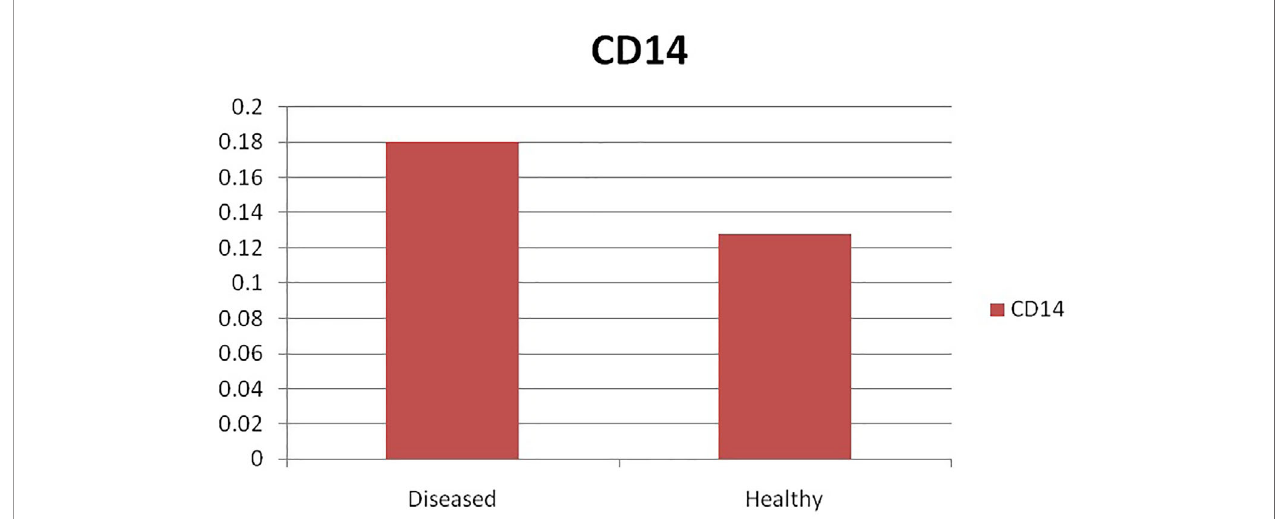
FIGURE 9 | Differential mRNA expression pro fi ling of ovine CD14 with respect to non-infected and infected (Haemonchus